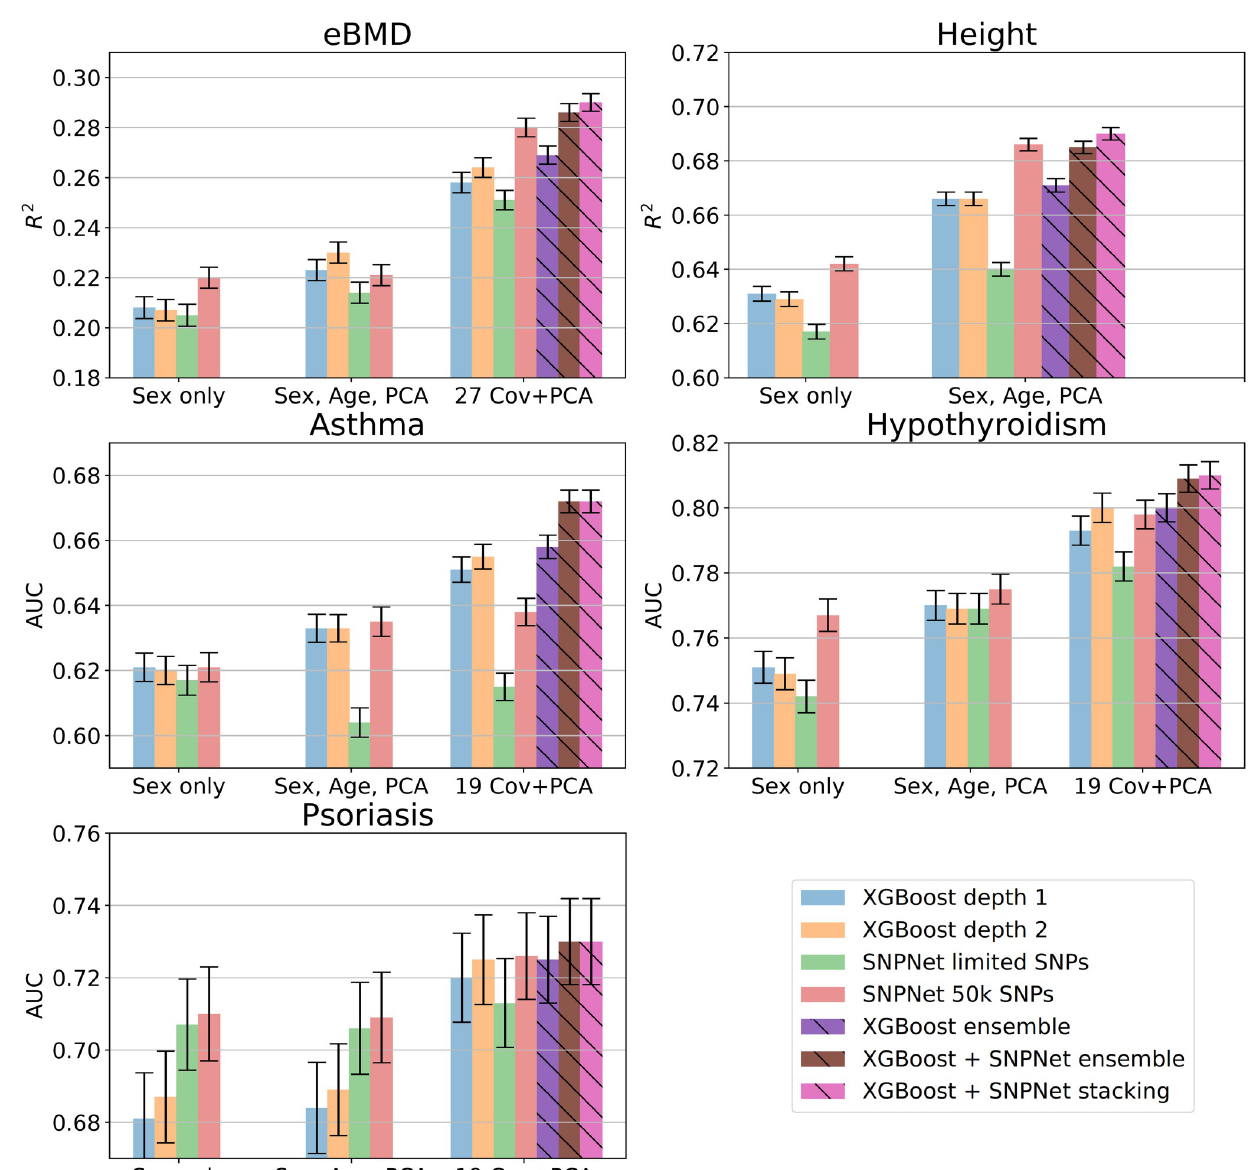
Fig 3. Prediction performance for all five phenotypes. Performance metrics ( r 2 , AUC) and their standard deviations are computed on an independent test set. The total height of error bars is two standard deviations.